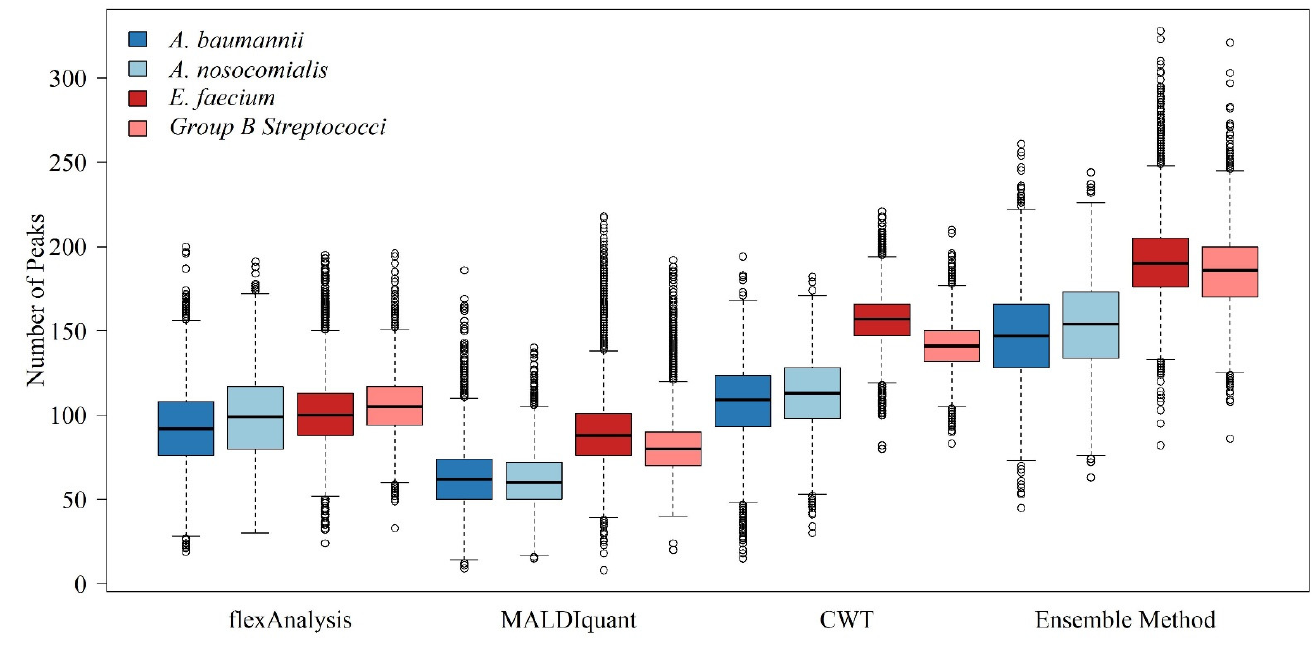
Figure 1. Boxplots of the numbers of peaks with different preprocessing methods for A. baumannii , A. nosocomialis , E. faecium , and Group B Streptococci .